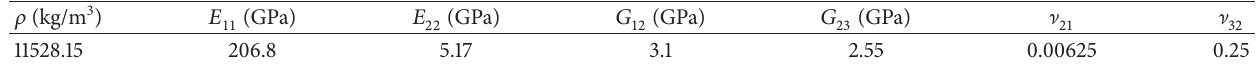
Table 1: Mechanical properties of composite material [5].